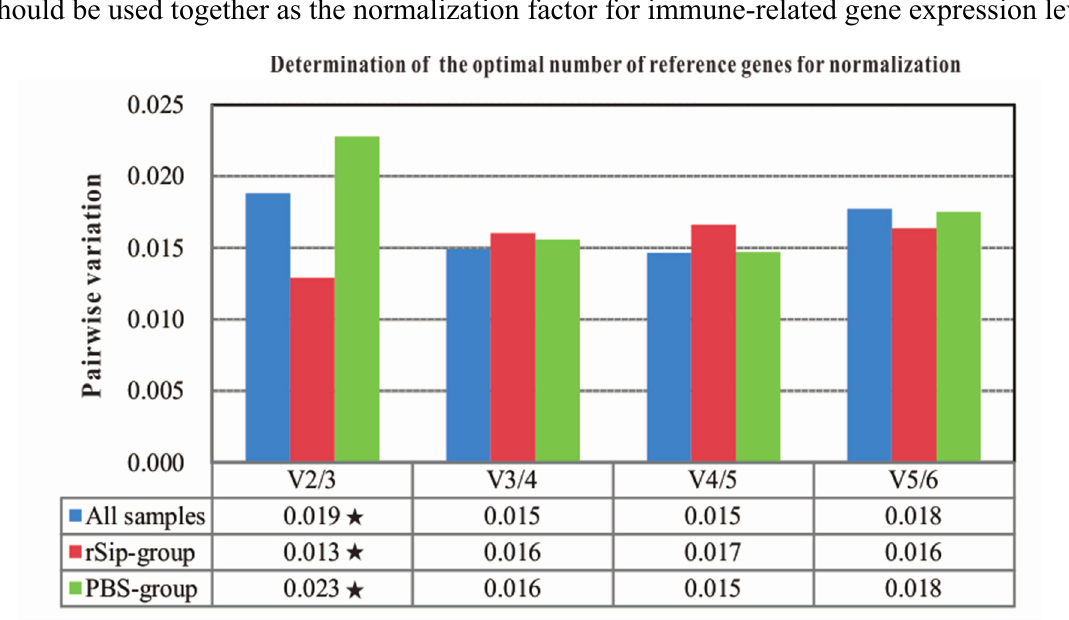
Figure 3. Pairwise variation analyses of candidate reference genes in different experimental sets with GeNorm programs. Pairwise variation (V) was calculated to determine the minimum number of reference genes required for accurate normalization in different experimental sets. V2/3 means the number of required reference genes is suggested two. V3/4 means the number of required reference genes is suggested three, and so on. “ ★ ” indicates the value of pairwise variation less than the recommended 0.15 for each experimental